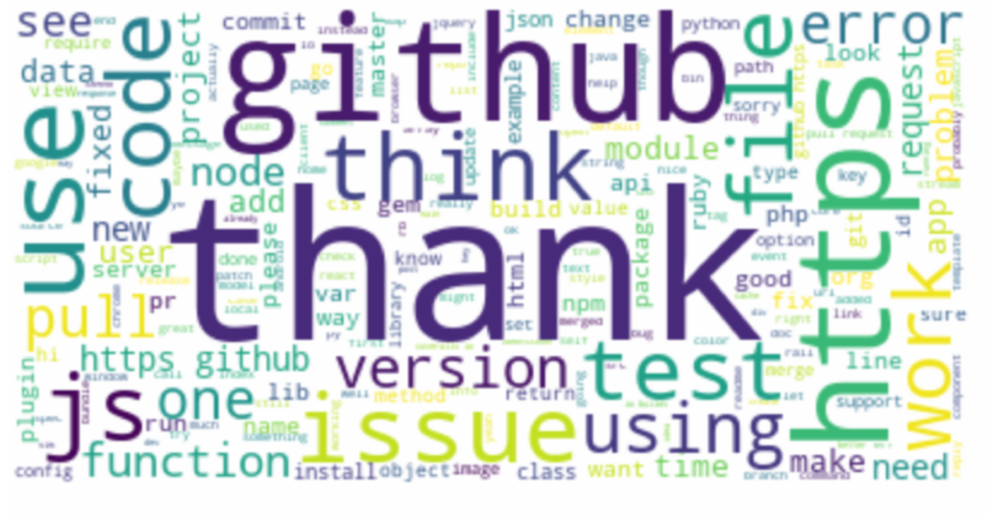
Figure 2. The corpus of comments words at a